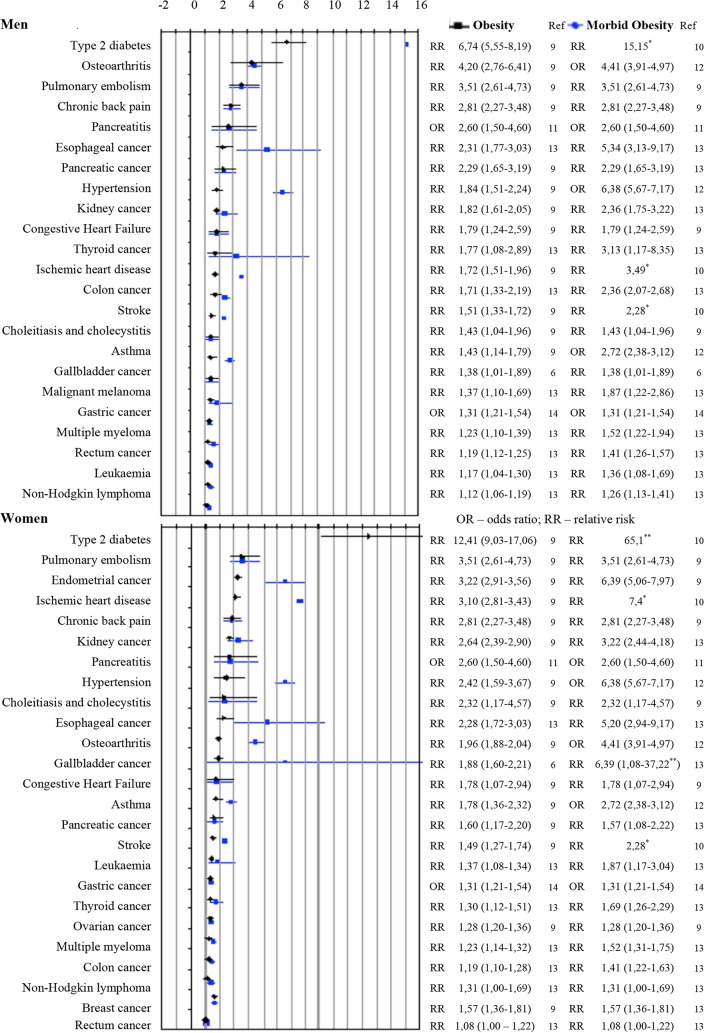
RR or OR for diseases associated with obesity (BMI ≥ 30 kg/m2) and morbid obesity (BMI ≥ 40 kg/m2) in adults aged 20 and over, according to sex.Sources: 6WHO 2012, 9Guh, 2009, 10IASO (1) (*), 11Martinez, 2004, 12Mokdad et al, 2001, 13Renehan et al, 2008 (1), 14Yang, 2009. (1) RR calculated for the mean BMI of morbidly obese adults (BMI = 43.42 kg/m2) (*) In this study confidence interval for the RR were not calculated (**) outliers